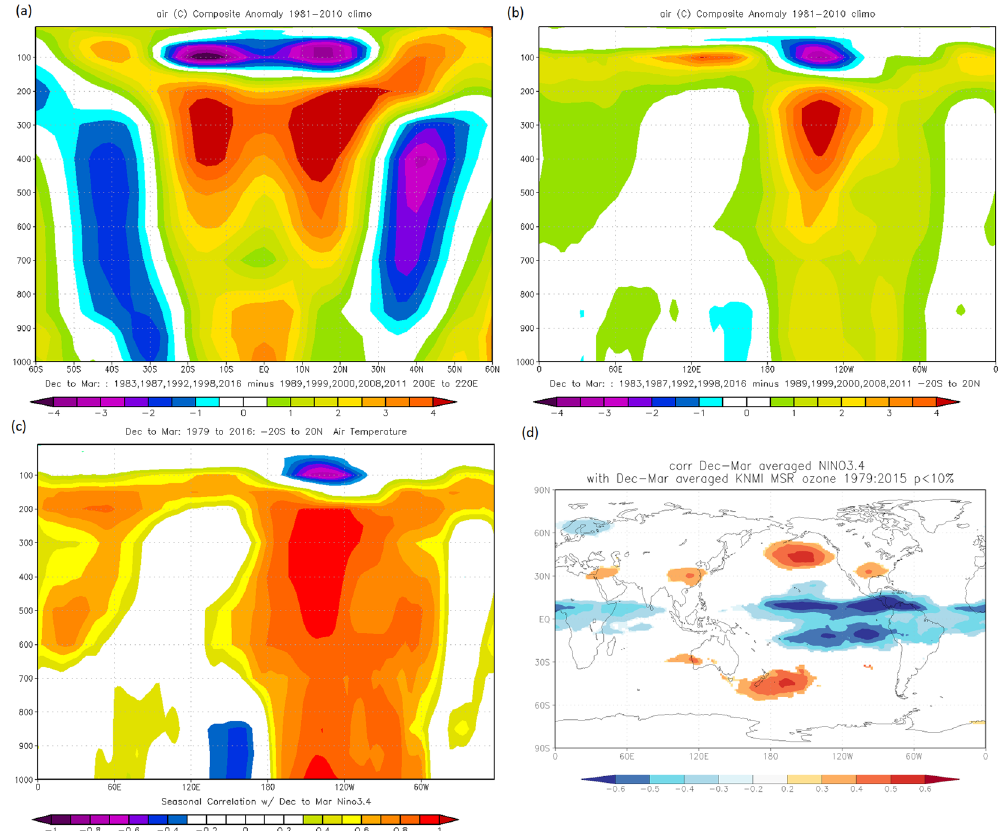
Figure 3. The El Nino minus La Nina mean difference composite spatial pattern for the ( a ) 200°E–220°E and ( b ) 20°N–20°S Z averaged vertical slice in temperature. Nino 3.4 correlation with ( c ) the 20°N–20°S temperature averaged vertical slice and ( d ) Total ozone column correlation field for the period 1980 to 2016. The years comprising the composites are indicated in ( a ) and ( b ). The figures ( a ) to ( c ) were generated from ref. 32 air temperature using the online software https://www.esrl.noaa.gov/psd/cgi-bin/data/composites/printpage.pl. Figure 3d was constructed from http://climexp.knmi.nl/corfield_obs.cgi with the ozone data are from